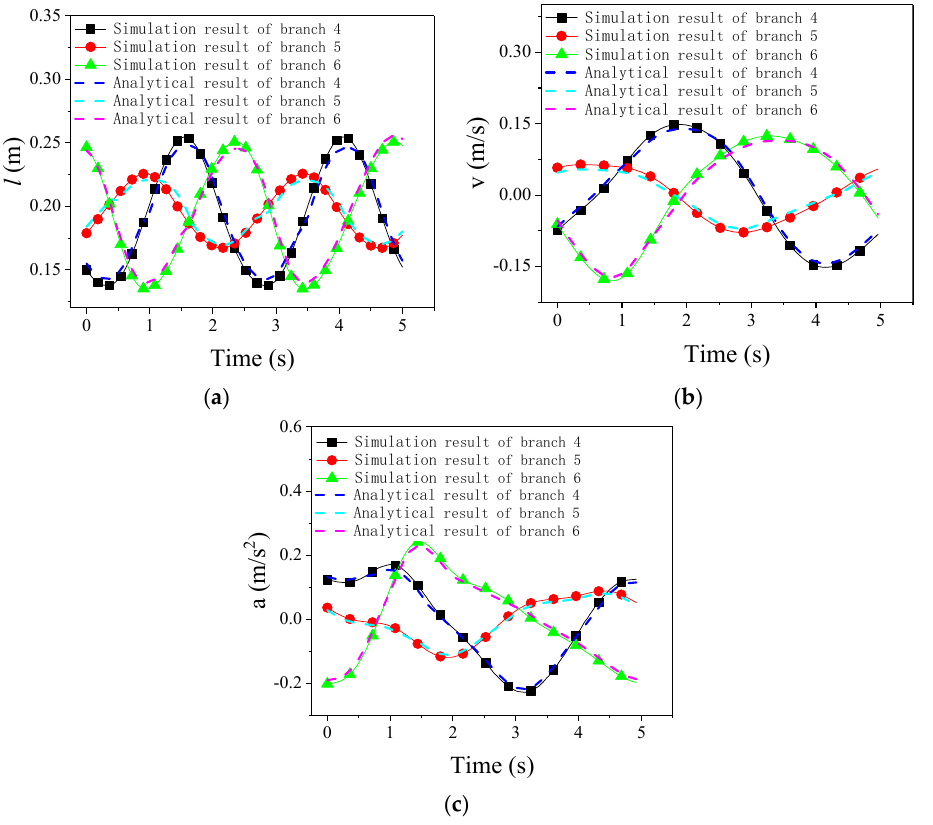
Figure 10. Displacement, velocity, and acceleration curves in the 3PUU moving part. ( a ) Displace- ment curves of each branched chain in 3PUU moving part; ( b ) velocity curves of each branched chain in 3PUU moving part; ( c ) acceleration curves of each branched chain in the 3PUU moving part.